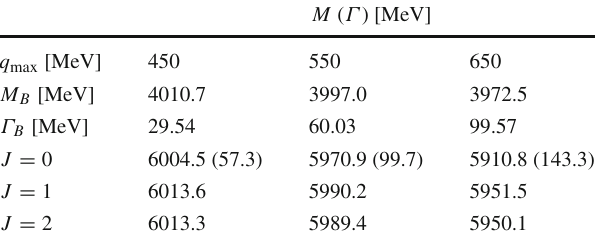
Table 2 Mass, M , and width, Γ , of the states found in the D ∗ D ∗ D ∗ system with isospin 1 / 2 and spin-parity J P = 0 − , 1 − and 2 − for different values of q max and taking into account the width of the